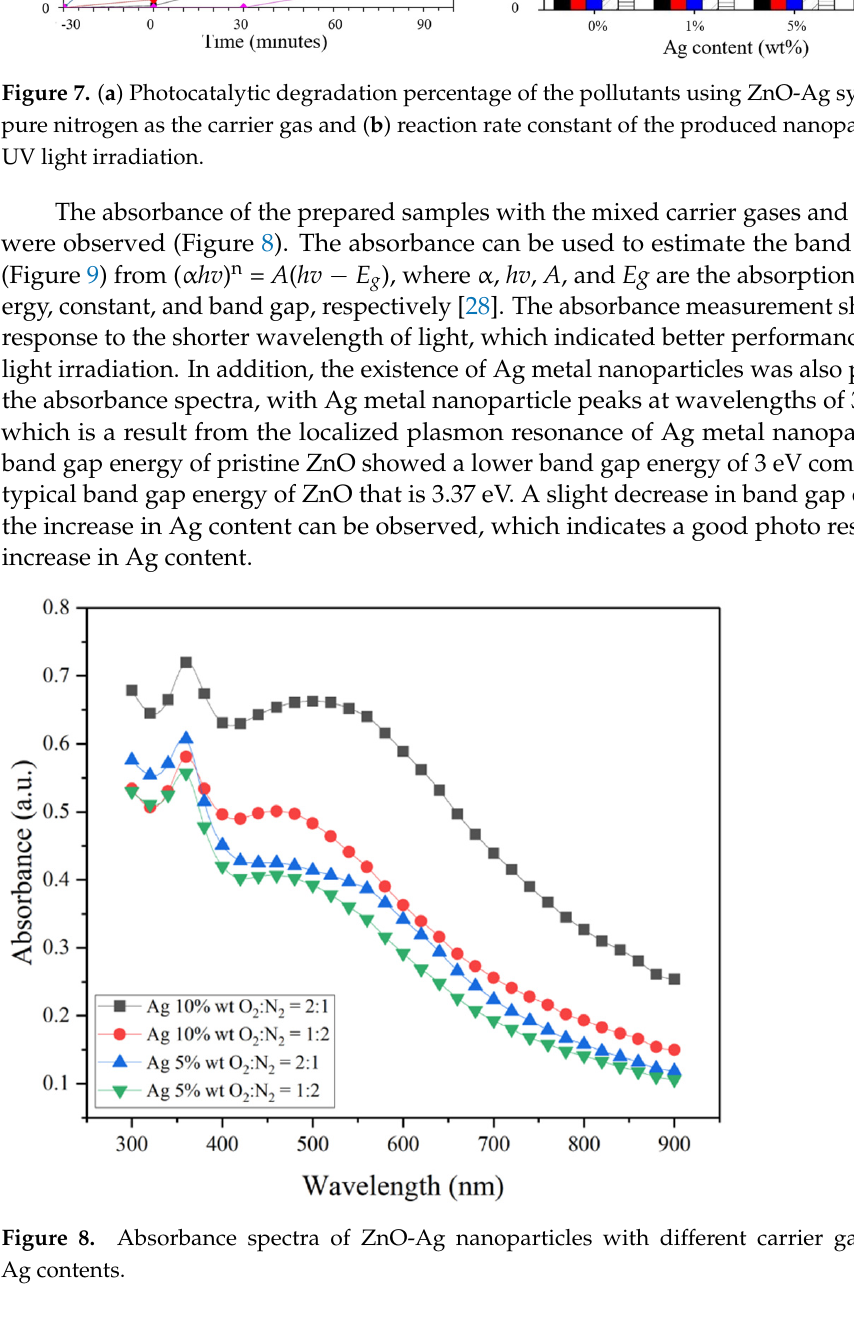
Figure 7. ( a ) Photocatalytic degradation percentage of the pollutants using ZnO ‐ Ag synthesized by